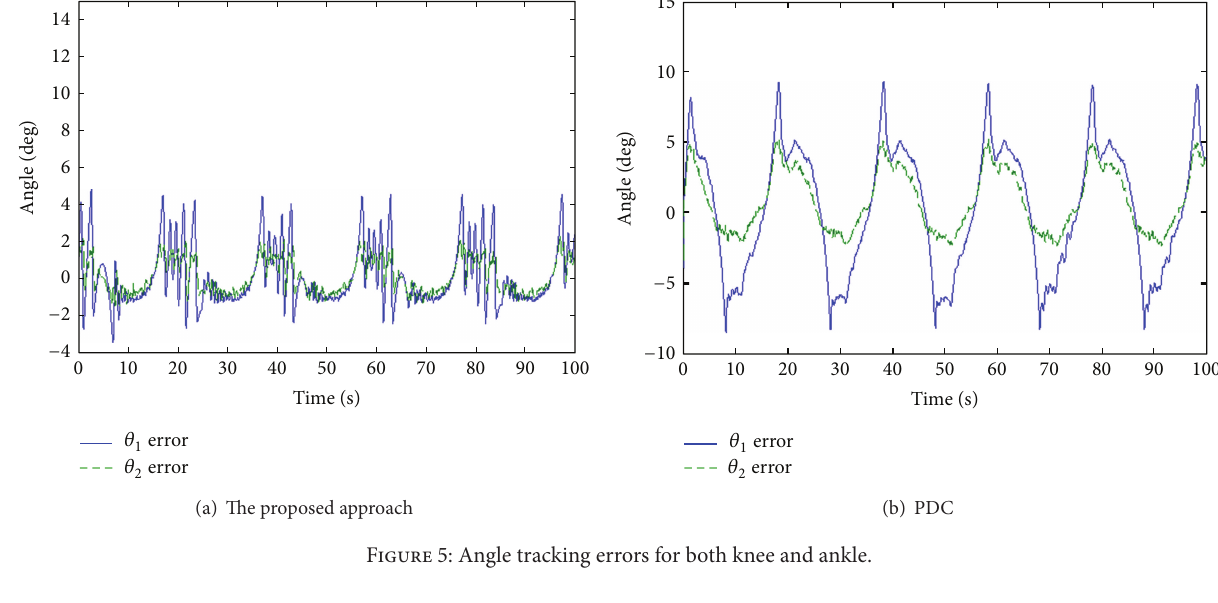
Figure 5: Angle tracking errors for both knee and ankle.